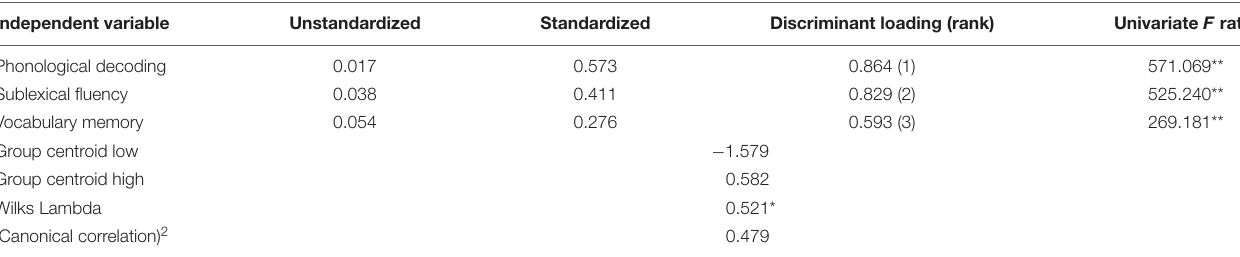
TABLE 6 | Summary of the test of significance of a set of discriminant functions. Independent